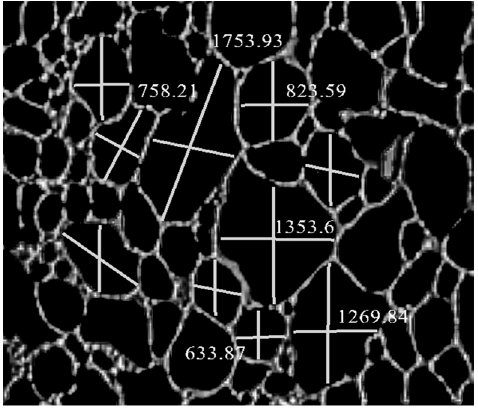
Figure 2 . Measurement of the pore diameter using Image Pro Plus software. Figure 2. Measurement of the pore diameter using Image Pro Plus software.